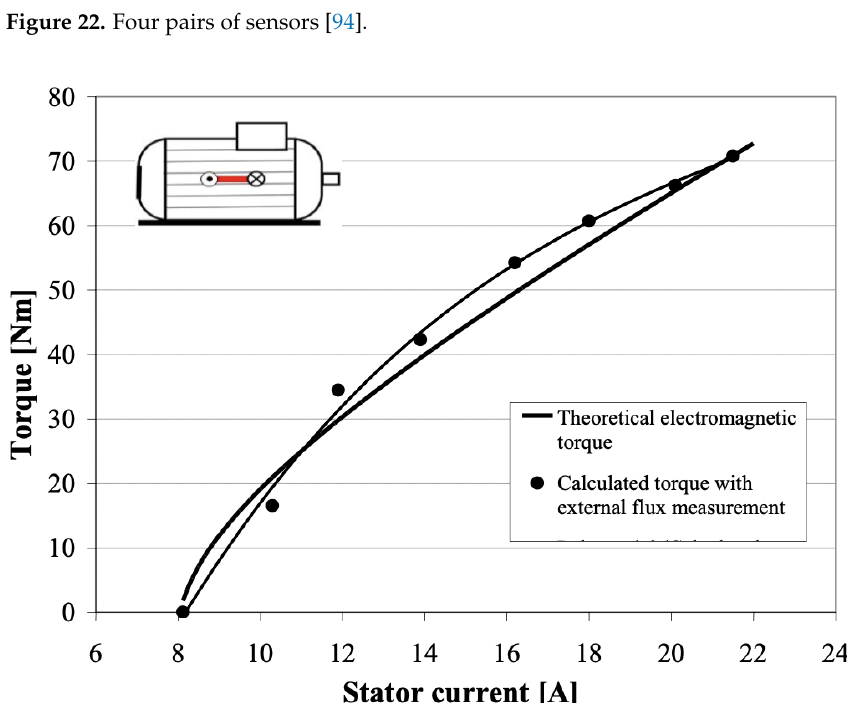
Figure 23. Theoretical and calculated torque